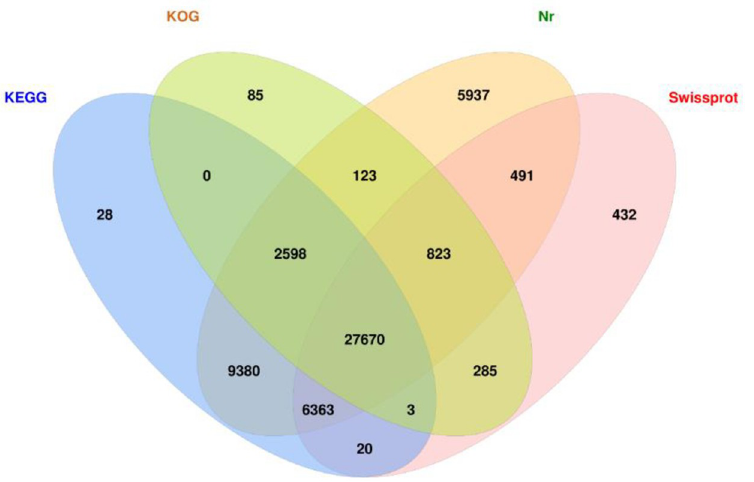
Fig 3. Annotation diagrams obtained form 4 major databases. (Distribution map of 4 major databases annotated to genes).